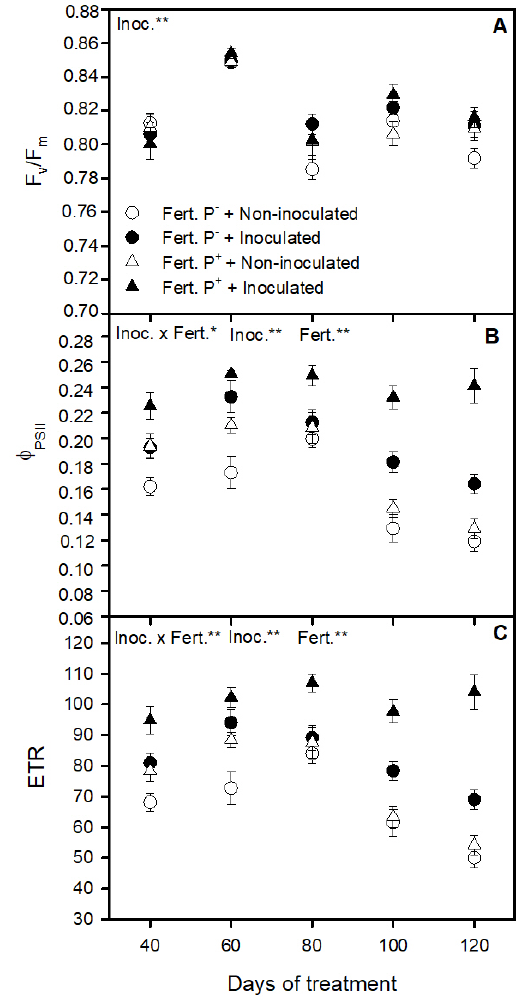
Figure 5. Maximum quantum efficiency of PSII photochemistry, F v /F m ( A ), actual efficiency of photosystem II, Φ PSII ( B ), and the electron transport rate, ETR ( C ) in strawberry plants fertilized with BNM medium without phosphorus (Fert. P − ) or with BNM medium supplemented with an insoluble phosphorus form (Fert. P+) and subjected to two inoculation treatments after 40, 60, 80, 100, and 120 days of treatment. Values represent mean ± SE of 10 replicates. For statistical details, see Figure 1 caption. (LSD test, * p < 0.05, ** p < 0.01).